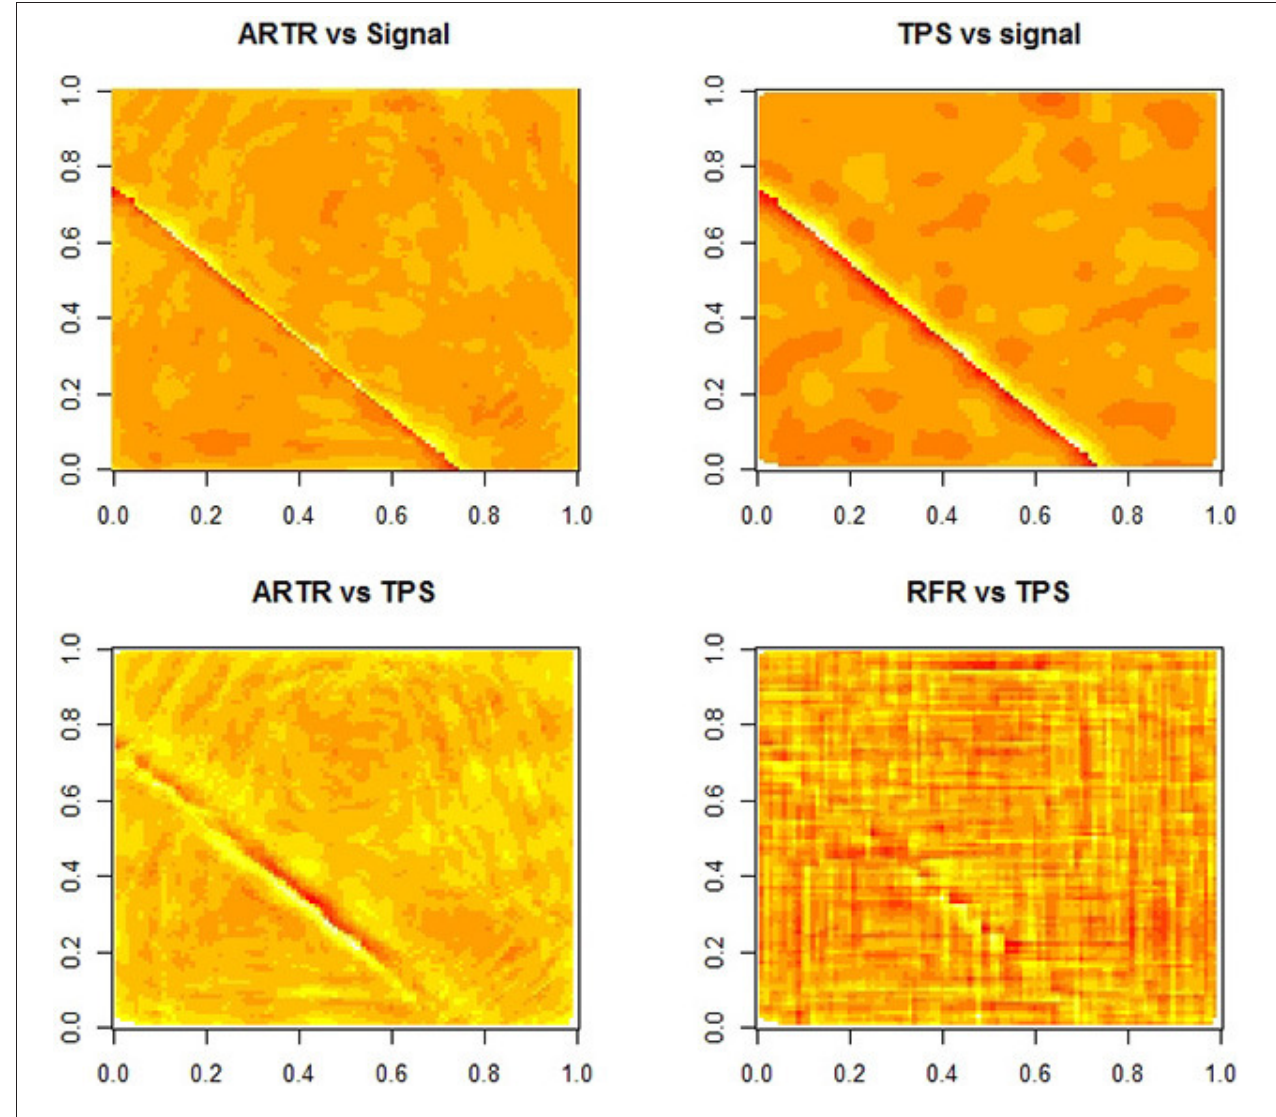
FIGURE 3 | Differences among the estimates. TABLE 3 | The mean squared approximation errors in example